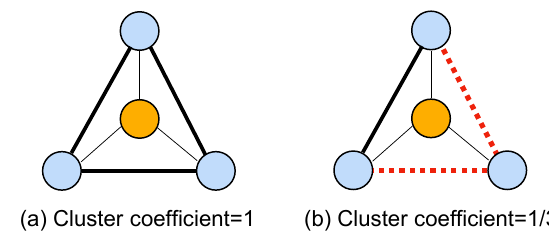
Fig. 3 An example network for illustration. Fig. 4 An example of cluster